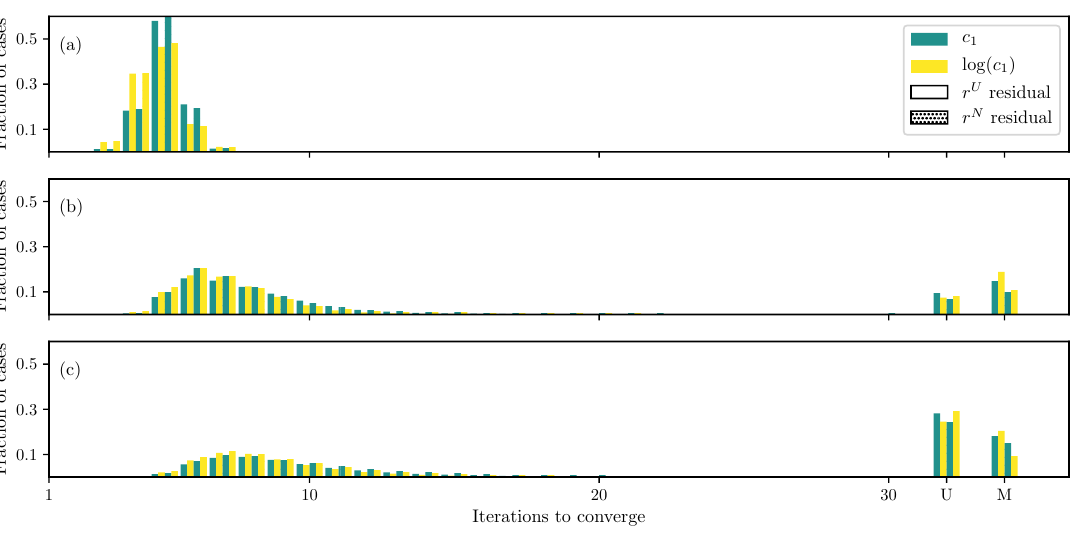
Figure 3. Iterations required using different formulations for the GOH (2) model force controlled (FC) case when ( a ) only c 1 and c 2 are unknown, ( b ) all parameters except the angle θ are unknown, and ( c ) all parameters are